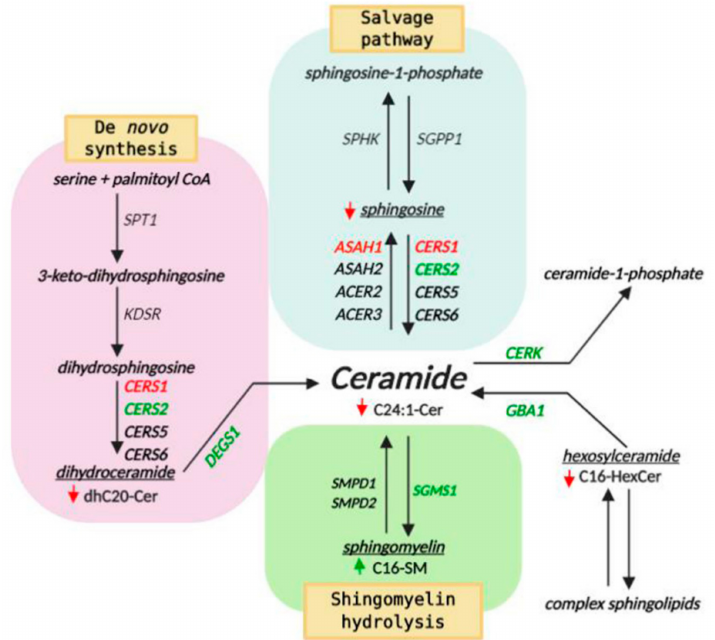
Figure 11. Altered sphingolipid and gene transcript levels in ASAH1 KD SH-SY5Y cells. Illustration of the three major metabolic pathways of ceramide biosynthesis: the de novo pathway (pink background), the salvage pathway (light blue background) and the sphingomyelin hydrolysis pathway (green background). Green arrows indicate an increase and red arrows indicate a decrease in the intracellular sphingolipid levels. Genes encoding enzymes involved in these pathways are shown in italics , with colors indicating significant up-regulation (green) and down-regulation (red) of corresponding mRNA. ASAH1 , lysosomal ceramidase; ASAH2 , plasma membrane ceramidase; ACER2 , golgi ceramidase; ACER3 , endoplasmic reticulum and golgi ceramidase; CERS1, 2, 5, 6 , ceramide synthases; DEGS1 , dihydroceramide desaturase; CERK , ceramide kinase; SGMS1 , sphingomyelin synthase 1; SMPD1 , lysosomal sphingomyelin phosphodiesterase 1; SMPD2 , neutral sphingomyelin phosphodiesterase 2; GBA1 , glucosylceramidase beta 1; SPT1 , serine palmitoyltransferase; KDSR , 3-ketodihydrosphingosine reductase; SPHK , sphingosine kinase; SGPP1 , sphingosine-1-phosphate phosphatase